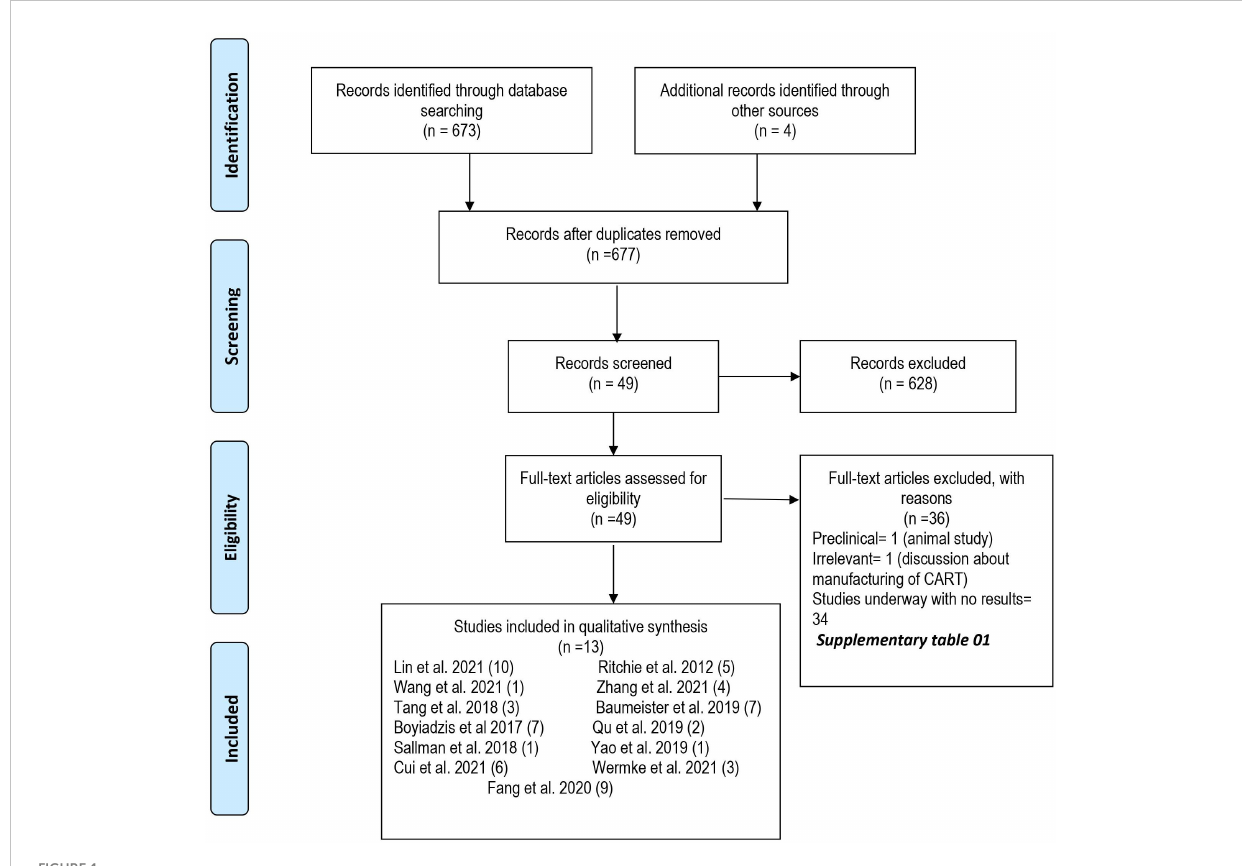
FIGURE 1 PRISMA Flow sheet of included and excluded